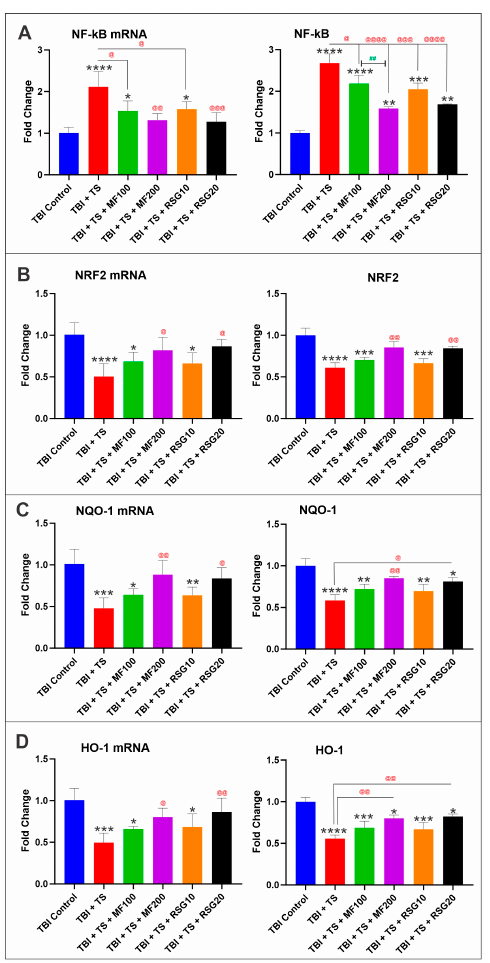
Figure 3. Dose-dependent protective effects of MF and RSG on the antioxidative response system in vivo. ELISA and quantitative RT-PCR analyses emphasized the antioxidative effects of MF and RSG on ( A ) downregulation of NF-kB and ( B ) activation of NRF2 expression levels in a dose-dependent manner. Changes in NRF2 expression levels were paralleled by corresponding variations in the expression levels of its downstream detoxifying effector molecules ( C ) NQO-1 and ( D ) HO-1. n = 6 biological replicates, * p < 0.05, ** p < 0.01, *** p < 0.001, **** p < 0.0001 versus control. @ p < 0.05, @@ p < 0.01, @@@ p < 0.001, @@@@ p < 0.0001 non-treated versus MF/RSG-treated group. ## p < 0.01MF100 versus MF200.